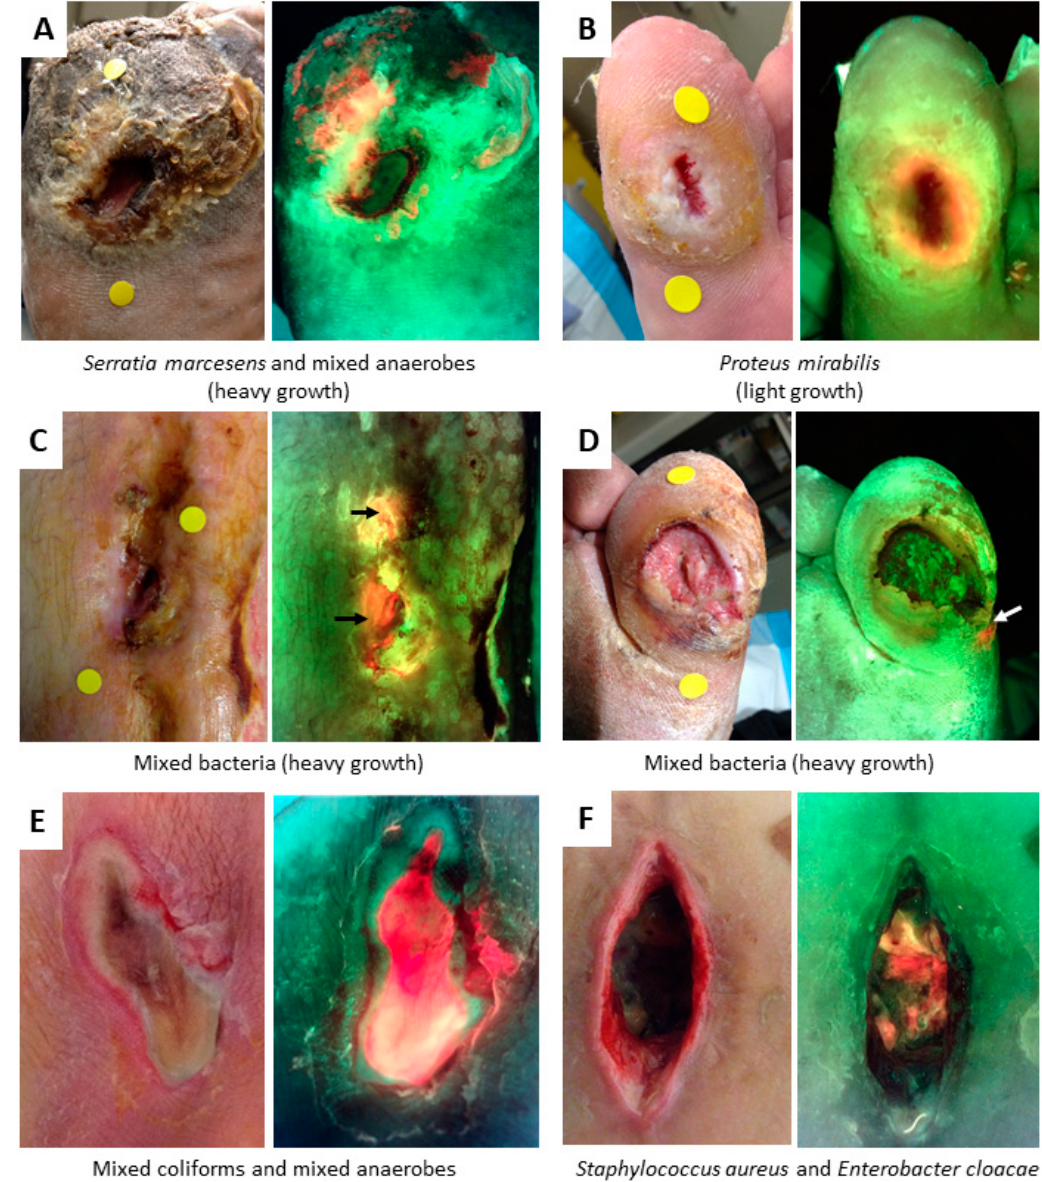
Figure 5. Fluorescence from bacteria appears red or pink/blush. Red fluorescence is a result of endogenous porphyrins emitted by most bacterial species when excited by 405 nm violet light. ( A – F ) All wounds show a standard image on left and fluorescence image on right, with microbiology results from cultures reported below. Circular yellow stickers seen in wounds A – D (standard images) are for the device’s wound measurement software. Wounds A , B, and D = DFU; wounds C and F = surgical; wound E = pressure ulcer (PU).